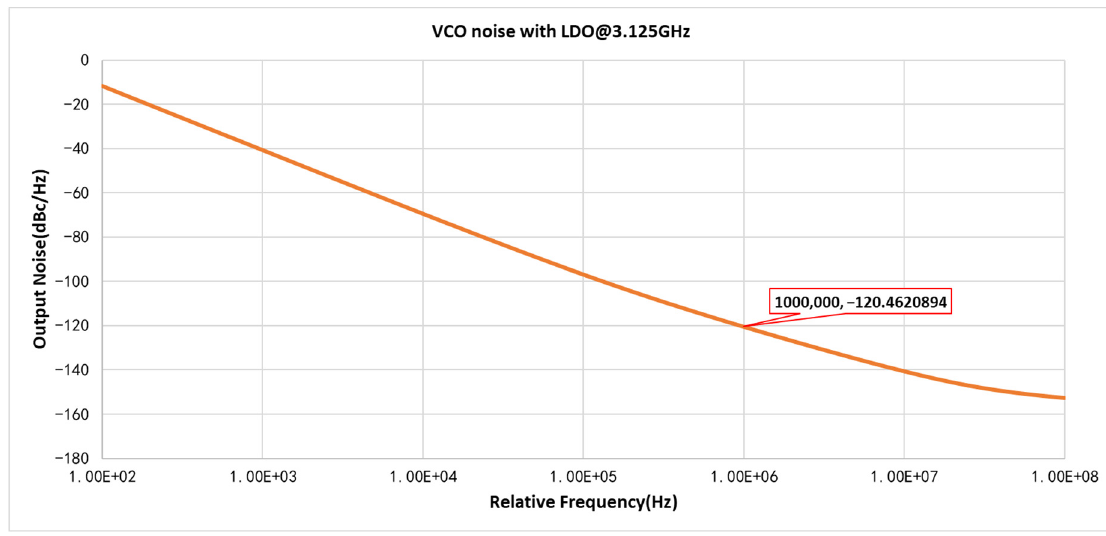
Figure 6. Layout of SerDes and PLL. RX: Receiver; PM: power management.